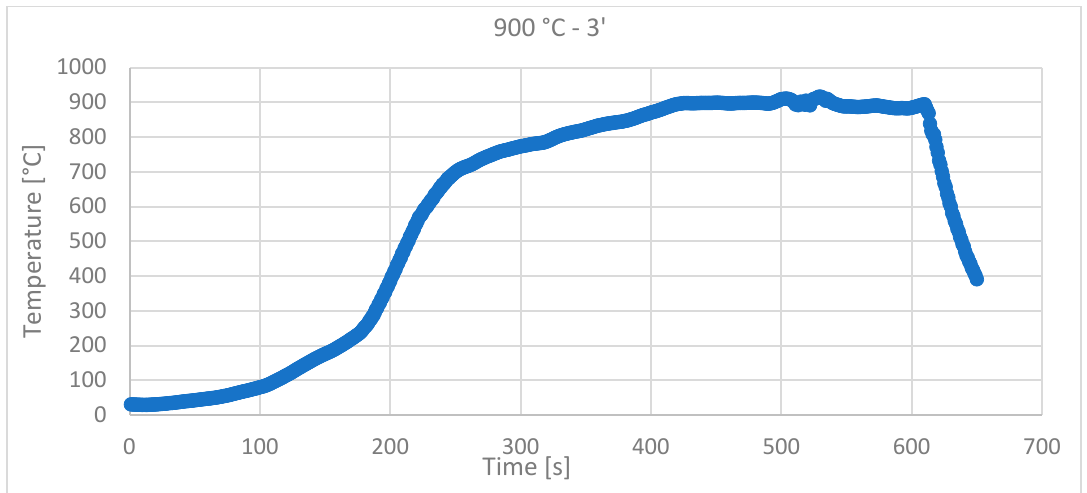
Figure 3. Solar sintering diagram at 900 °C, with 3 min holding time and with a 116.7 °C/min heating rate.